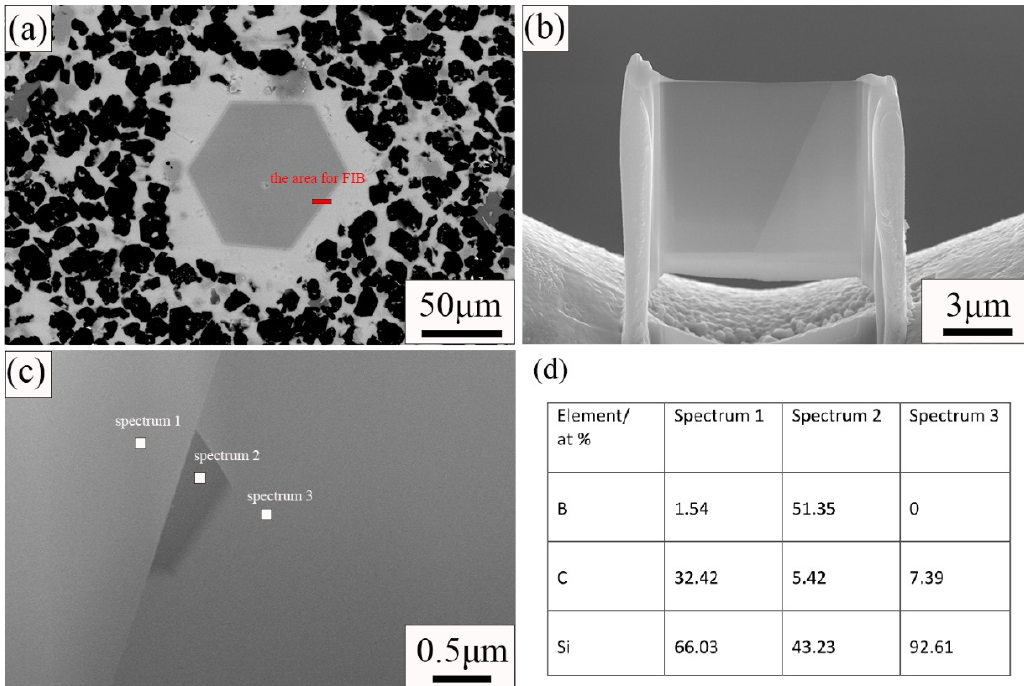
Figure 4. SEM and TEM images of C0 sample. ( a ) SEM image of C0 sample; ( b ) SEM image of sample cut by focused ion beam; ( c ) Dark field image of sample; ( d ) Results of EDS point